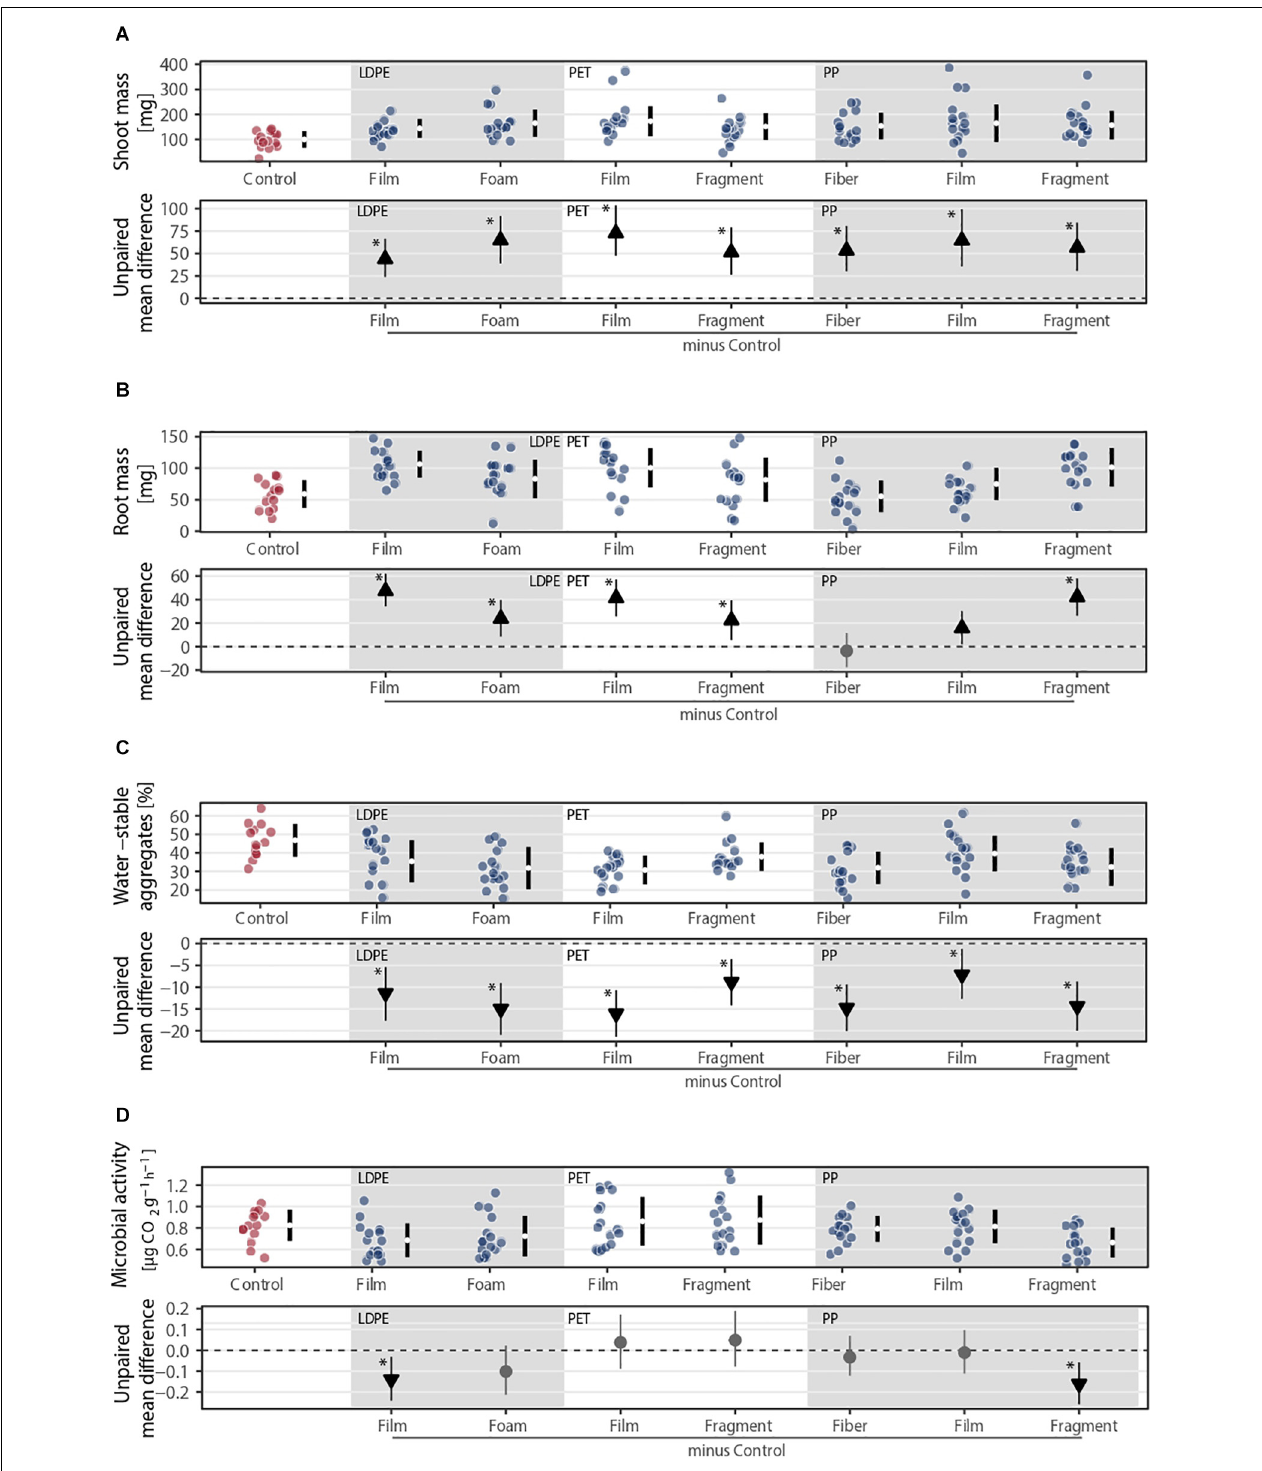
FIGURE 6 | Effects of the same polymer type in different shapes on (A) shoot and (B) root masses, (C) soil aggregation, and (D) microbial activity. Effect sizes and their variance are displayed as means and 95% confidence intervals. Effects are color-coded: gray circles indicate neutral effect sizes and black arrows with an arrow head pointing upward or downward indicate positive or negative effects, respectively. Horizontal dotted line indicates the mean difference value between each microplastic and the control. Low density polyethylene (LDPE), polyethylene terephthalate (PET), and polypropylene (PP) were selected as different shapes were made of these polymers. Significance was established at 0.05 ( Supplementary Table S4 ); n = 7 for microplastics, n = 14 for control samples.